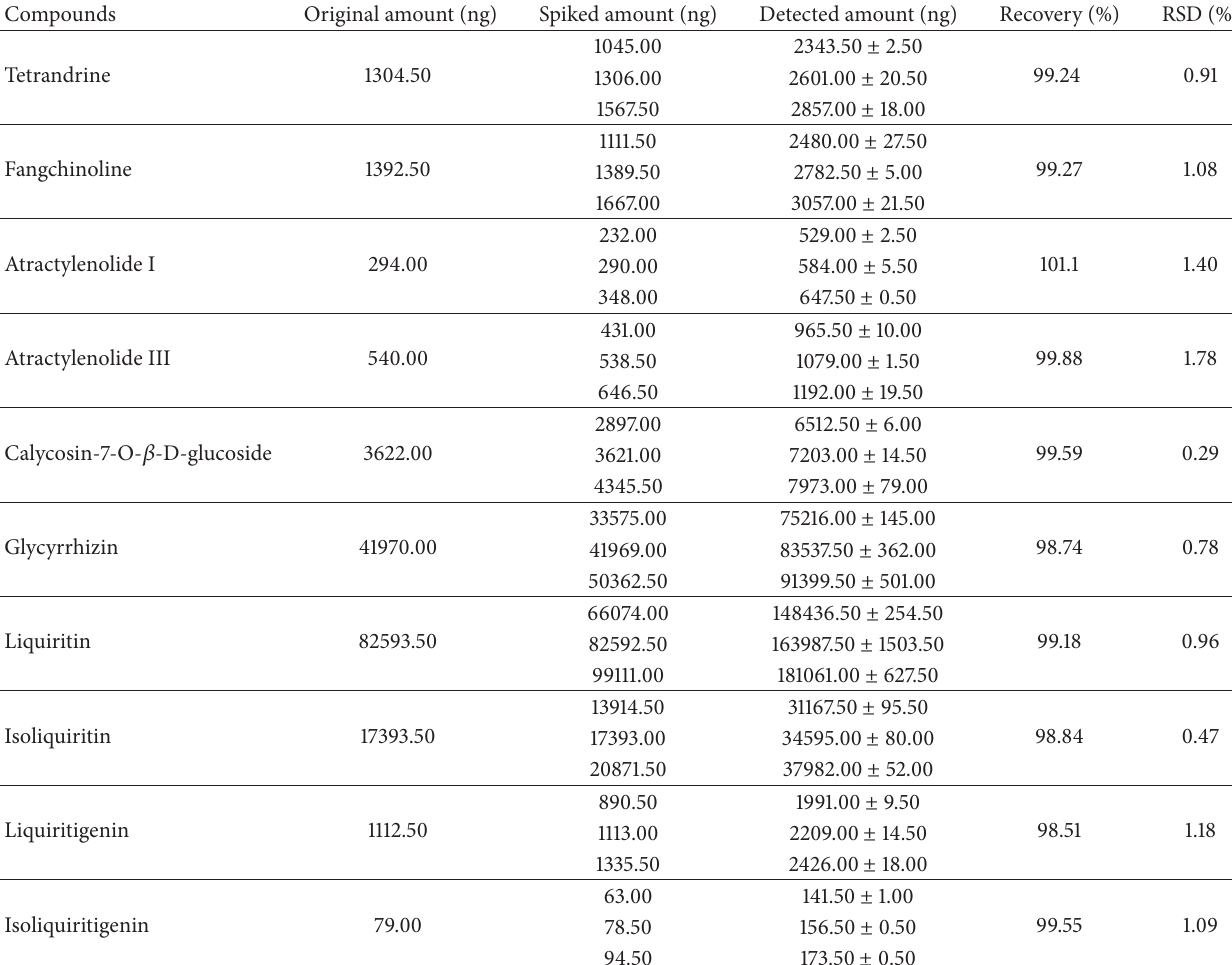
Table 4: Recovery of the 10 major compounds in Fangji Huangqi Tang ( 𝑛 = 3